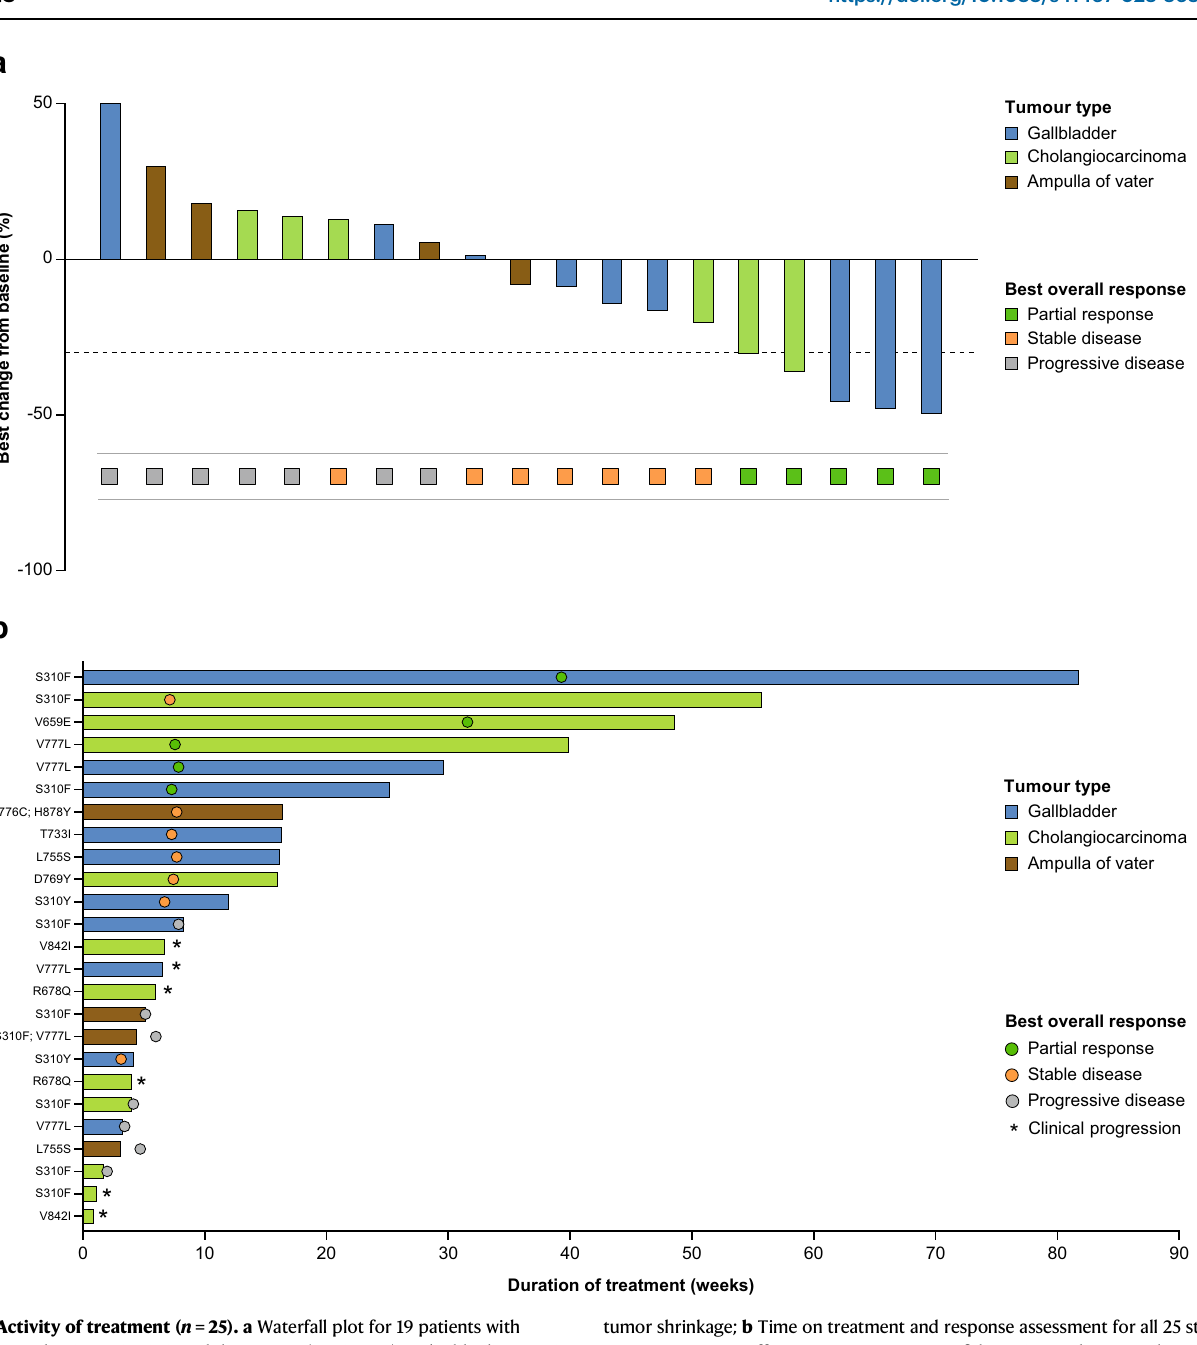
tumor shrinkage; b Time on treatment and response assessment for all 25 study patients. Data cut-off: January 22, 2021. CI con fi dence interval. Source data are provided as a Source Data fi